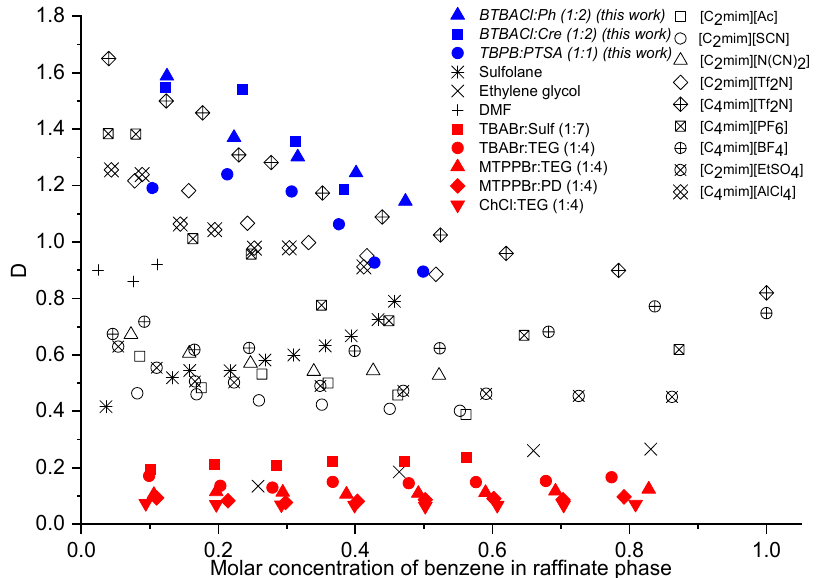
Figure 8. Distribution ratio of organic solvents, ILs, and ESs for the extractive separation of benzene and